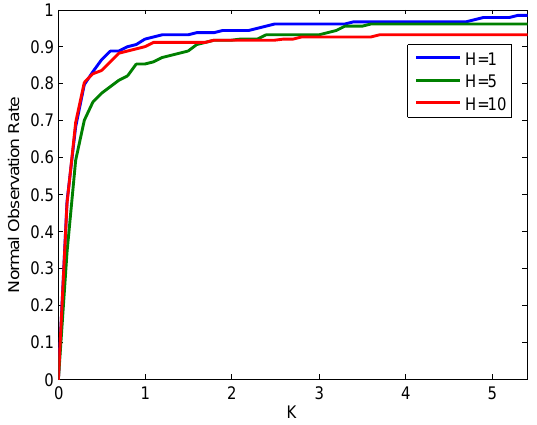
Figure 6. Normal observation rate when varying K .